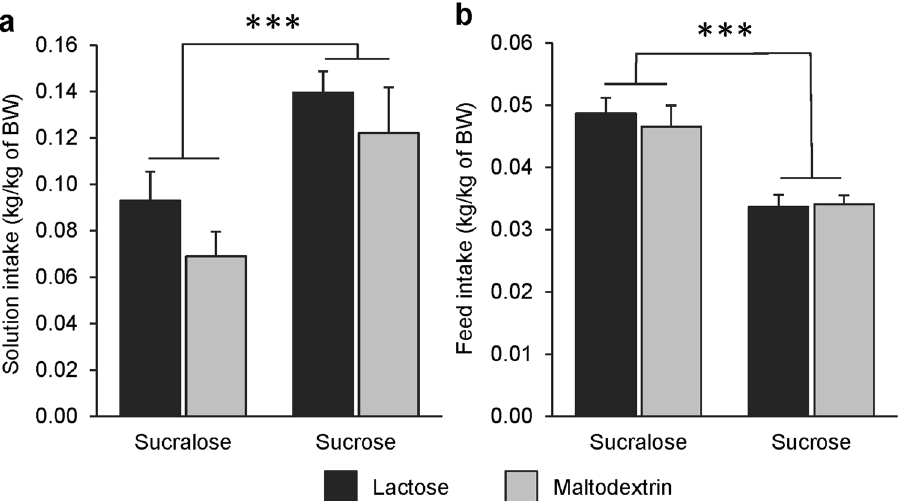
Figure 5. ( a ) Intake (kg/kg of body weight) of sucralose or sucrose solutions offered during 30-min single- solution tests to piglets fed either a lactose-based formula or a maltodextrin-based formula from 1 to 9 weeks of age. ( b ) Intake (kg/kg of body weight) of feed during the first 4 hours following the distribution of the solutions. Data are expressed as means ± SEM and were analysed with a mixed model. *** p < 0.001 (main effect of